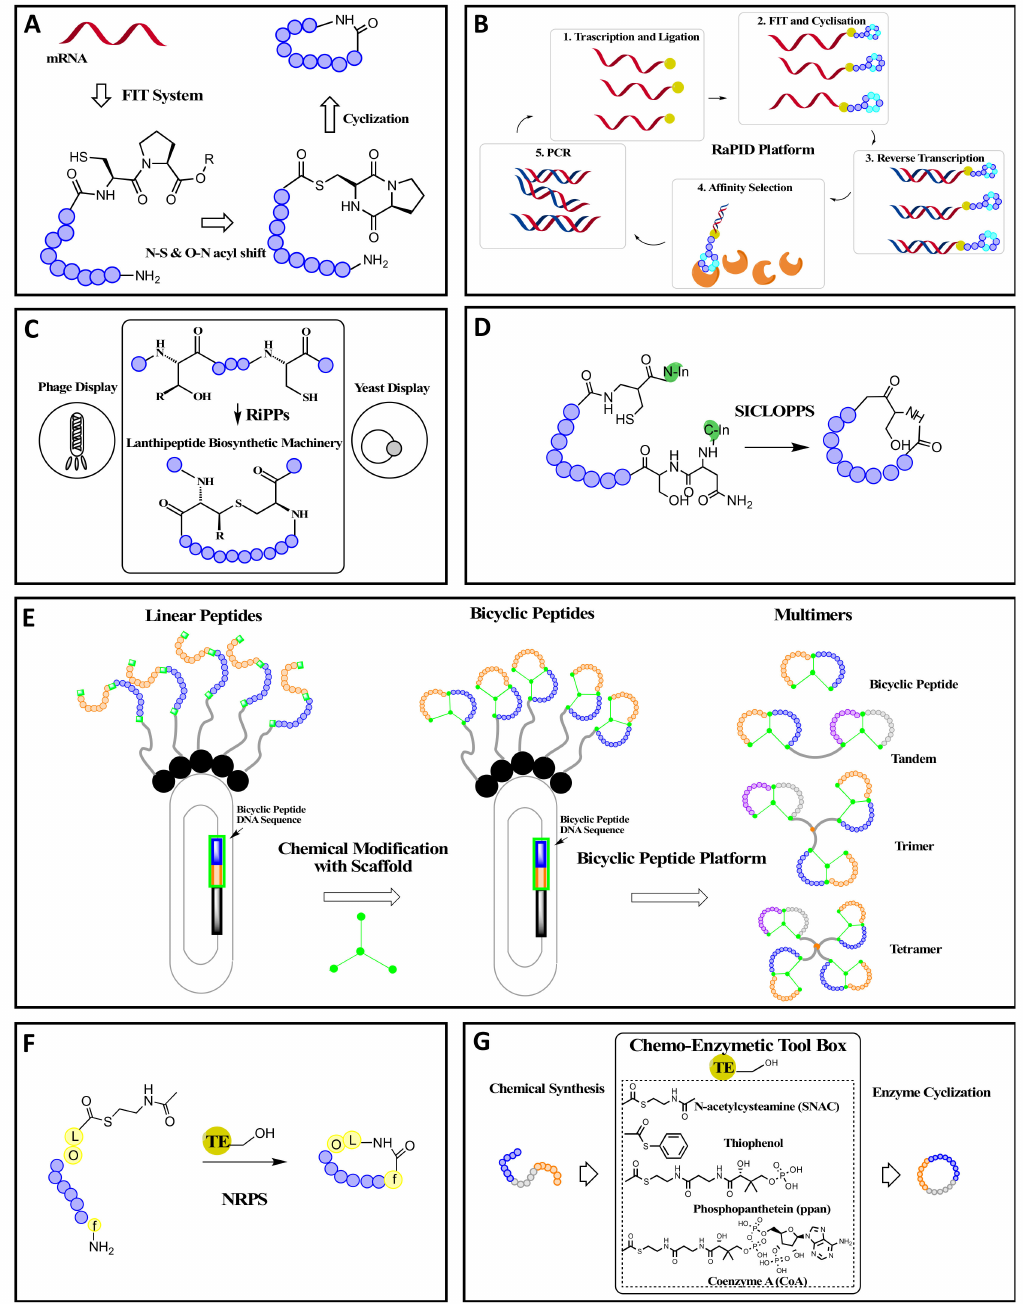
Figure 2. Illustrations of cyclic peptide synthesis platforms. ( A ) FIT (adapted from [3] with permission from The Royal Society of Chemistry); ( B ) RaPID (adapted from [37] with permission from The Royal Society of Chemistry); ( C ) RiPPs (adapted from [20]); ( D ) SICLOPPS (adapted from [47]); ( E ) Bicyclic peptide synthesis based on phage display and chemical cyclization (adapted from [48] and Bicycle Therapeutics website https://www.bicycletherapeutics.com (accessed on 21 May 2021); ( F ) NRPS (adapted from [47]); and ( G ) Chemo-enzymetic synthesis (adapted from [13]). (FIT: flexible in vitro translation; RaPID: random nonstandard peptides integrated discovery; RiPPs: ribosomally synthesized and post-translationally modified peptides; SICLOPPS: split-intein circular ligation of peptides and proteins; NRPS: non- ribosomal